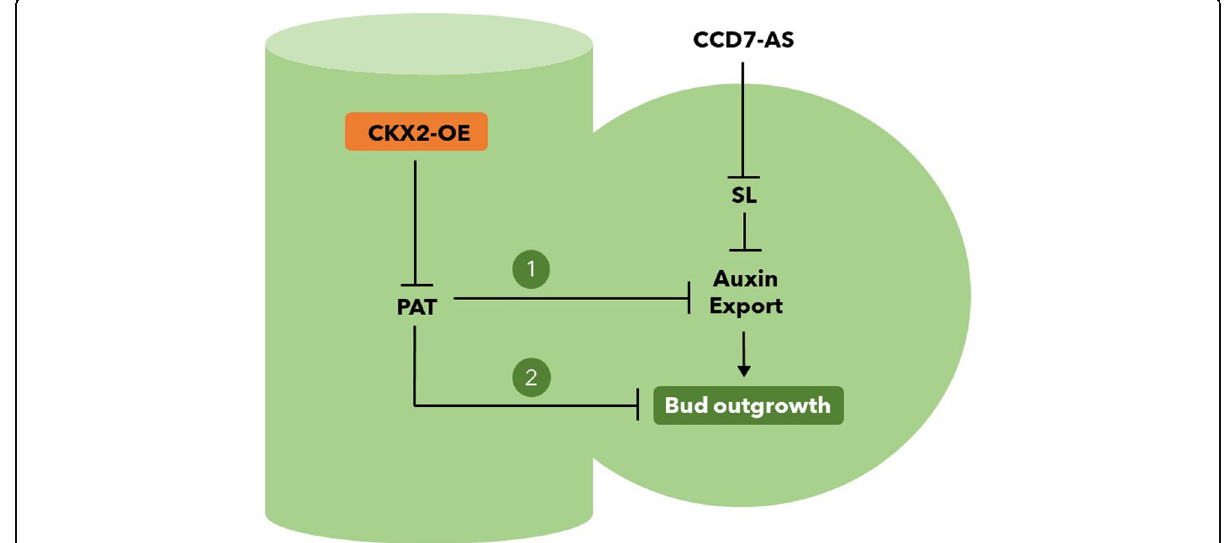
Fig. 7 Working model for the role of CKX2 in tomato shoot branching. The inhibition of polar auxin transport (PAT) in the stem by the overexpression of CKX2 (CKX2-OE) could release bud outgrowth mediated (1) or not (2) by auxin export in the bud. It is well known that PAT competitively inhibits auxin export from the axillary buds, which is a prerequisite for bud outgrowth (Barbier et al., 2018). Strigolactone (SL) also inhibits auxin export, which can be reverted in CCD7-AS plants. The additive phenotype of the double transgenic CKX2-OE, CCD7-AS plants (see Fig. 4) could be the consequence of the magnification of the convergent realease of auxin export (1) or due to another unknown mechanism (2) where CKX2-OE and CCD7-AS plants act in parallel pathways controlling bud